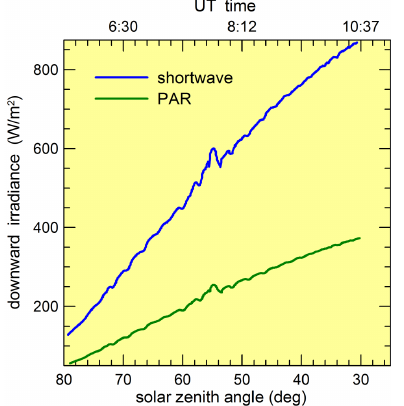
Fig. 1. Evolution of the downward shortwave and PAR irradiances measured at Lampedusa during the morning of September 7, 2005.